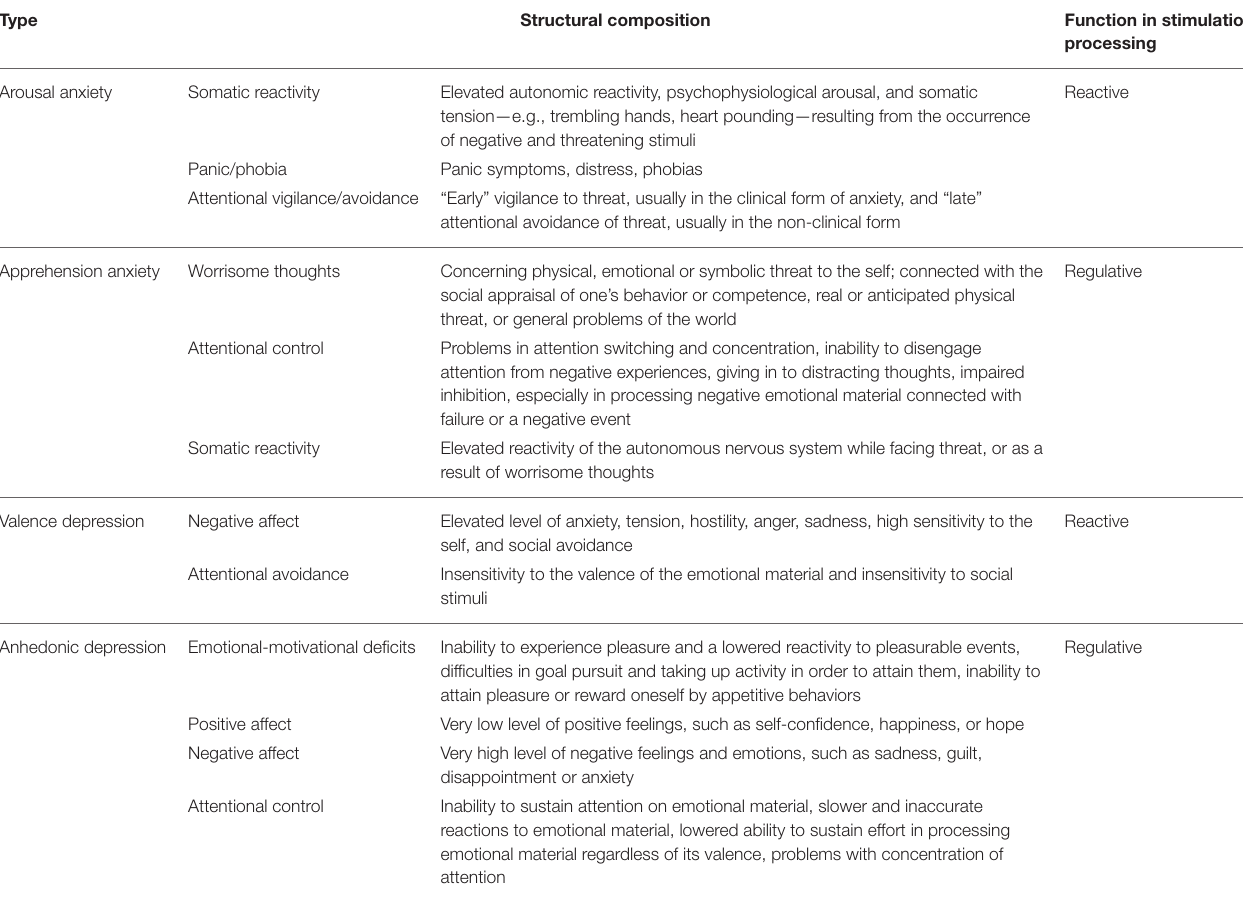
TABLE 2 | Structural composition of the anxiety and depression types and their functions in stimulation processing (Fajkowska et al., 2018).